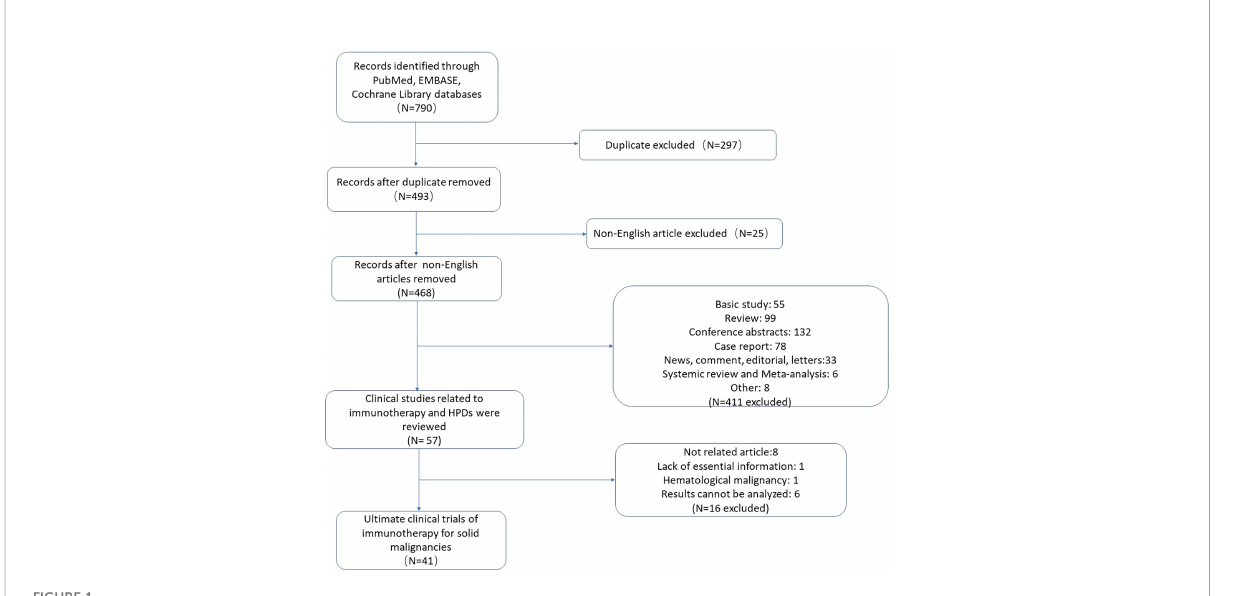
FIGURE 1 Flow chart of literature selection